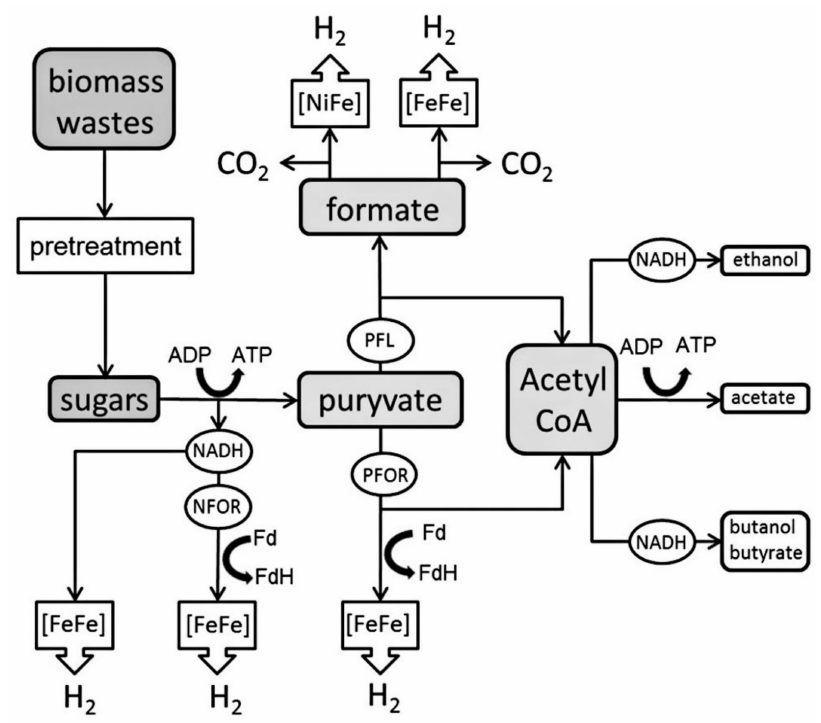
Figure 7. Characteristic metabolic ways for converting substrate to hydrogen during DF [76]. Repro- duced with permission from Elsevier,